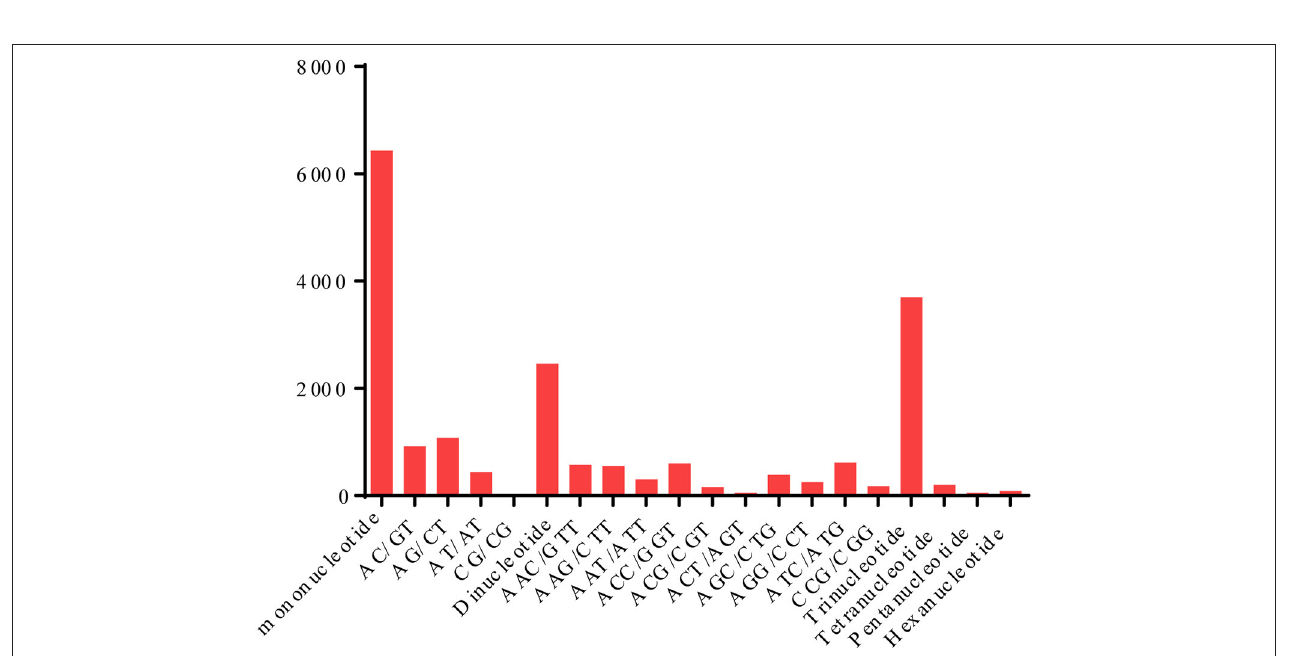
FIGURE 6 | Simple sequence repeat (SSR) types present in the C. rhombifolium transcriptome.